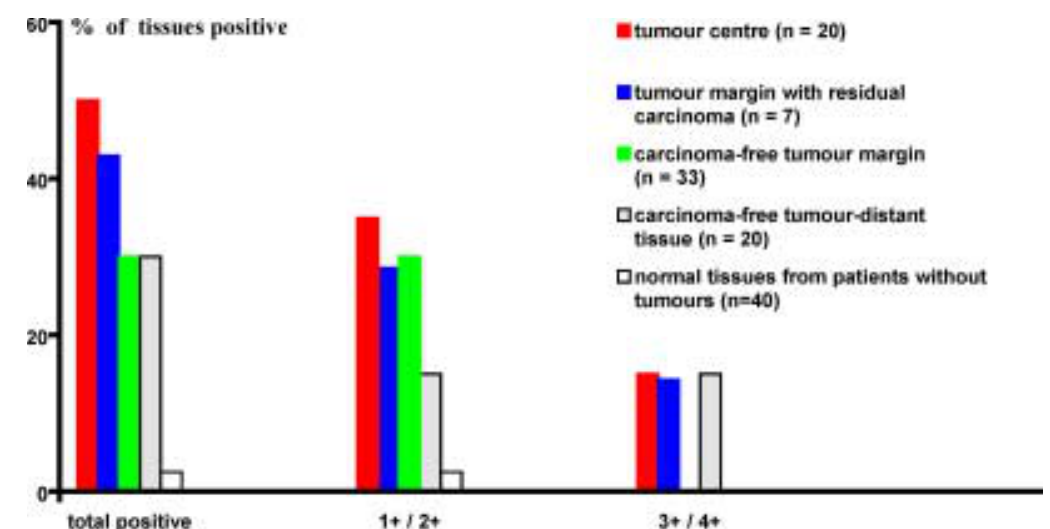
Fig. 2. Telomerase activity in the tissue samples examined. Values of telomerase activity: negative = 0–150 mOD; 1 + = 150–450 mOD; 2 + = 450–750 mOD; 3 + = 750–1050 mOD; 4 + = above 1050